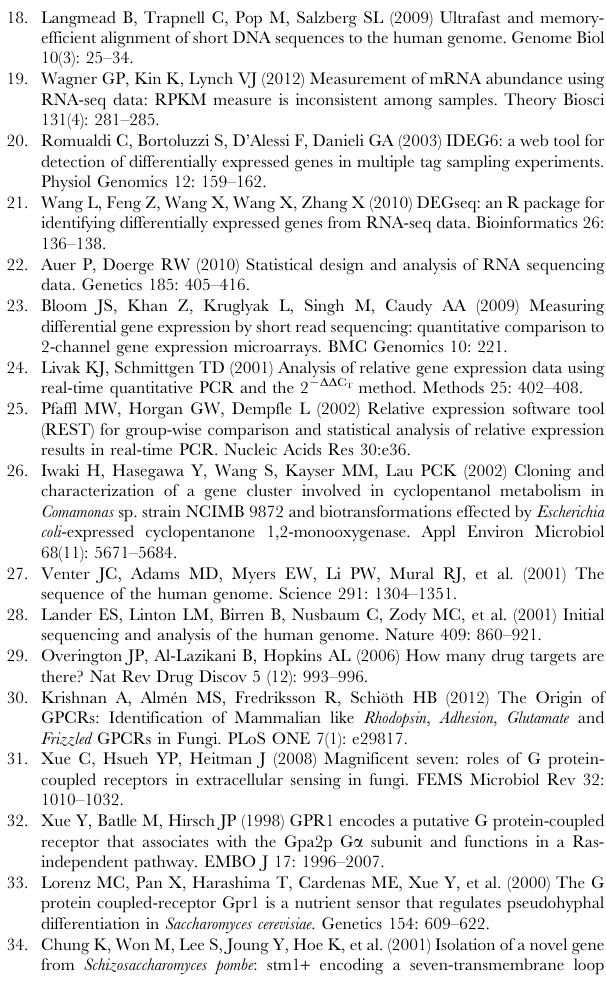
Figure S1 Verticillium dahliae strain XJ2008 (AB551191) isolated from diseased cotton plant in Xinjiang prov- ince, China. A, colony morphology on PDA; B, a single microsclerotium produced by strain XJ2008. C, branched conidiophores, which form whorls capped with flask-shaped and pointed phialides carrying terminal conidia. (TIF) Figure S2 RNA-seq results of Verticillium dahliae microsclerotia. A, histogram of the number of reads for genes in VDM library. B, histogram of the number of reads for genes in VDMG-b library. C, boxplot of read counts for each library. D, scatter plot comparing the number of reads for each gene between VDM and VDMG-b libraries. (TIF) Figure S3 Number of differential expressed genes between the libraries of germinating/germinated (VDMG-b) and non-germinated (VDM) Verticillium